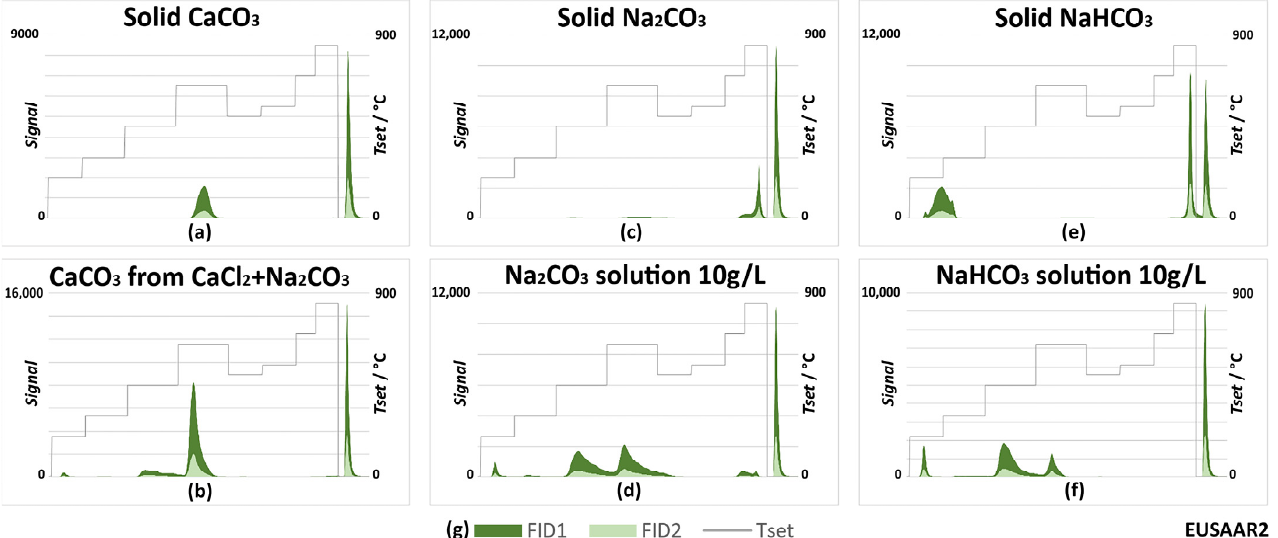
Figure 11. Carbonates’ behaviors with the EUSAAR2 TOT protocol (the protocol applied to the snow samples): thermograms ( a ) for calcium carbonate; ( b ) for calcium carbonate obtained by precipitation from aqueous solution; ( c ) for solid sodium carbonate; ( d ) for sodium carbonate by deposition from solution; ( e ) for sodium bicarbonate; ( f ) for sodium bicarbonate by deposition from solution; ( g ) legend for all